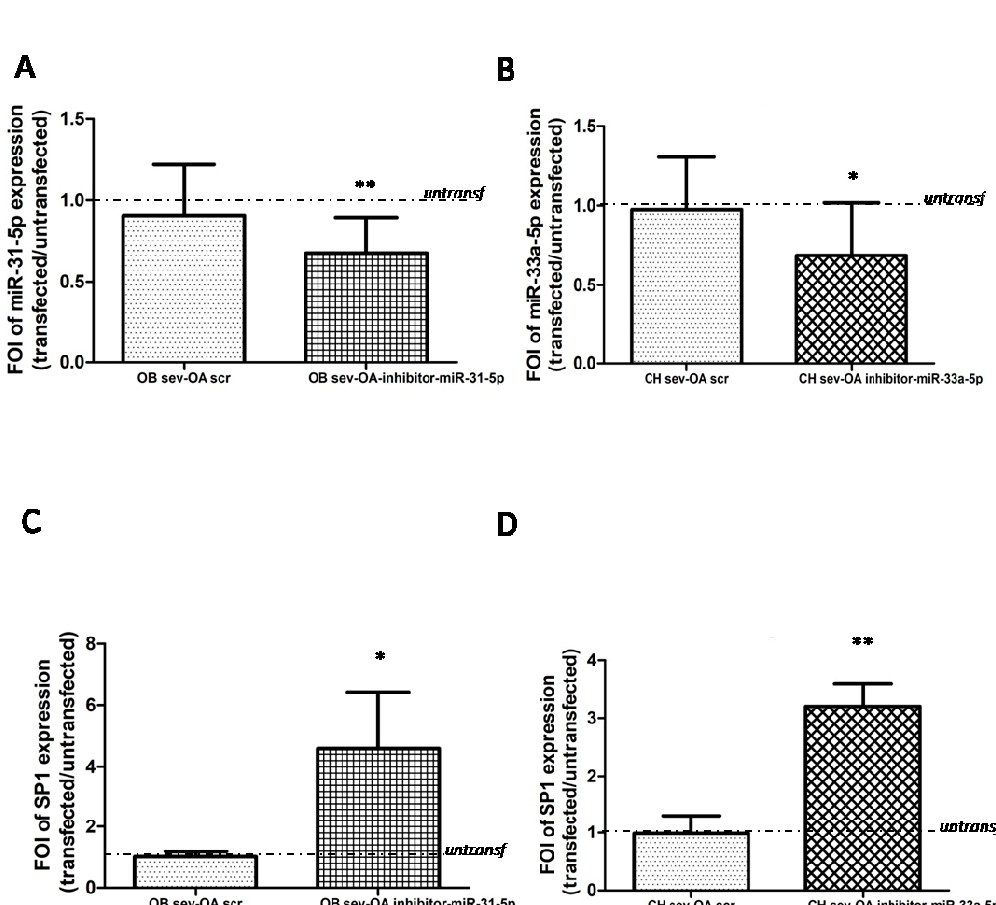
Figure 5. Study of SP1 gene expression modulation by gain and loss of function assays. Osteoblasts (OB) and chondrocytes (CH) isolated by OA patients after 24 h of transfection with miR-31-5p inhibitor for OB cells and with miR-33a-5p inhibitor for CH cells and relatives scrambles were analyzed for the gene expression of SP1 by qRT-PCR analysis. ( A ) The efficiency of miR-31-5p inhibitor and relative scrambles transfection was evaluated in transfected severe OA-derived OB versus untransfected ones. ( B ) The efficiency of miR-33a-5p inhibitor and relatives scramble transfection was evaluated in transfected severe OA-derived CH versus untransfected ones. SP1 gene expression evaluated in ( C ) OB isolated from severe OA patients transfected with miR31-5p inhibitor and negative scramble, and in ( D ) CH isolated from severe OA patients transfected with miR-33a-5p inhibitor and negative scramble. Quantitative RT-PCR data are expressed as fold of change (FOI) in miRNAs or gene expression (2 − ∆∆ Ct ) occurred in transfected OA derived cells vs untransfected ones. Data reported were analysed by Student t test: *, p < 0.05, **, p < 0.005, between experimental group and represented as mean ± SD ( n = 4).